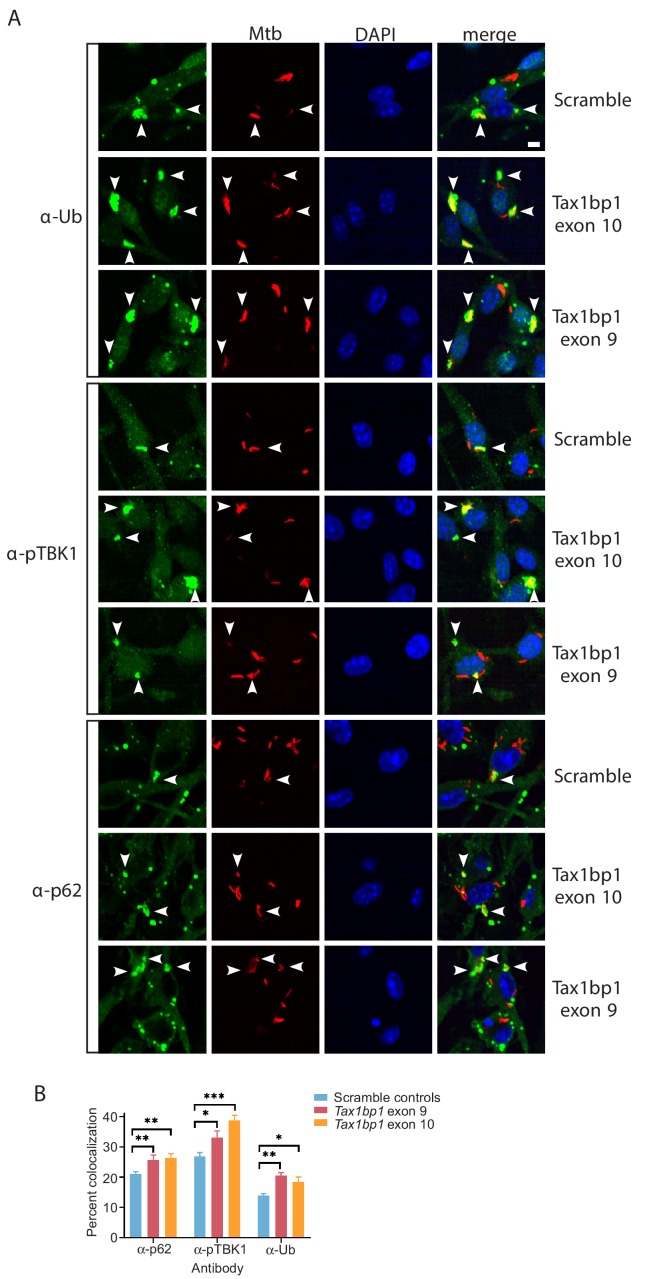
Accumulation of Mtb targeted to ubiquitin (FK2), p62, and phospho-TBK1 in TAX1BP1 edited macrophages.(A) Fluorescence images of bone-marrow-derived macrophages transduced with scramble control guide RNAs or Tax1bp1 exon 10 or nine guide RNAs infected with mCherry-expressing Mtb (red) and immunostained with antibodies to ubiquitin (FK2), p62, or phospho-TBK1 (green). Nuclei were stained with DAPI (blue). White bar denotes 10 µm. (B) Quantitative analysis of Mtb colocalization with ubiquitin, p62, and phospho-TBK1 at 8 hr post-infection. Results are the means ± SEM of four technical replicates. * p value less than 0.05 by t-test. ** p value less than 0.01. *** p value less than 0.001.